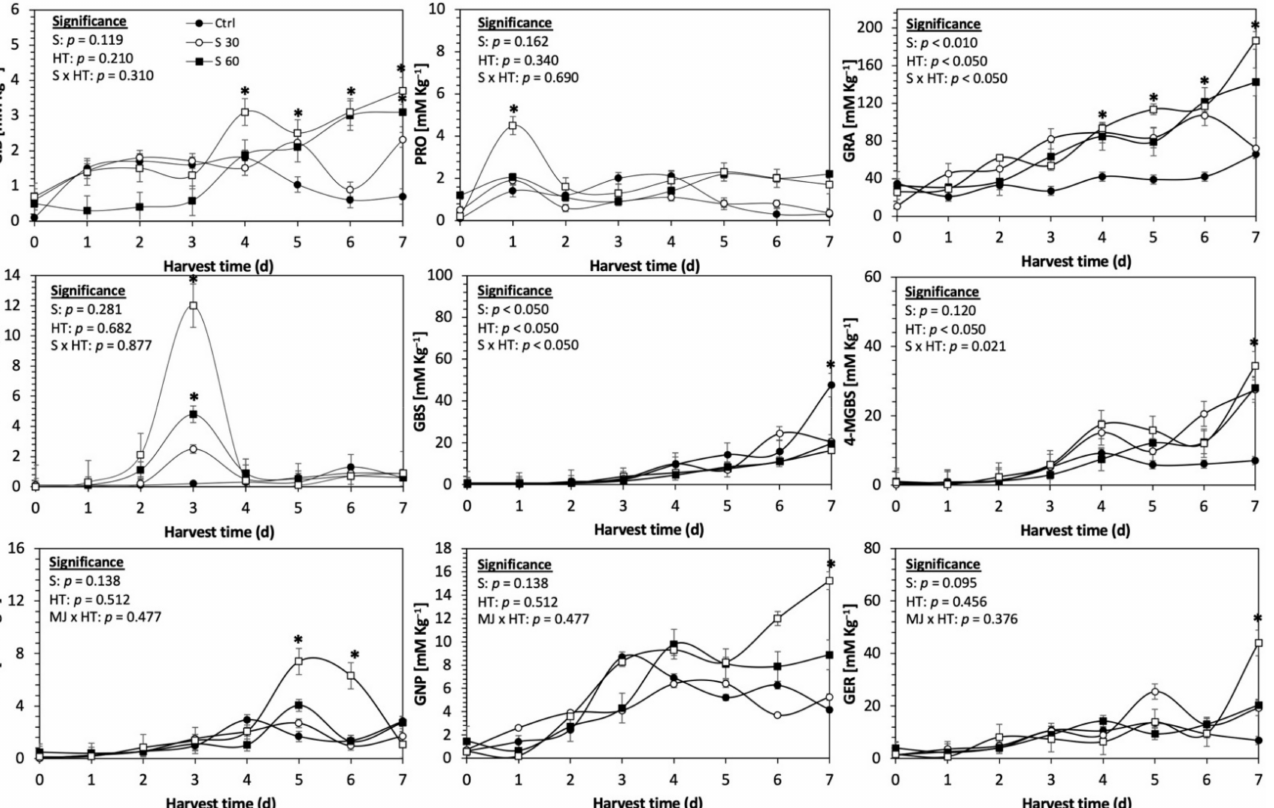
Figure 8. Concentration of individual glucosinolates in untreated Dwarf Green kale sprouts and treated with sulfur during the first 7 days of germination. Bars are means of 3 replicates ± standard error. Data points with an asterisk (*) indicate statistical difference determined by a t -test ( p < 0.050) be- tween the control and treated samples. Abbreviations: sulfur (S), harvest time (HT), glucoiberin (GIB), progoitrin (PRO), glucoraphanin (GRA), 4-hydroxy-glucobrassicin (4-HGB), glucobrassicin (GBS), 4-methoxy-glucobrassicin (4-MGBS), glucoeurocin (GER), gluconapin (GNP), and neoglucobrassicin (NGBS). Results are expressed as desulfogucoraphanin equivalents in dry weight